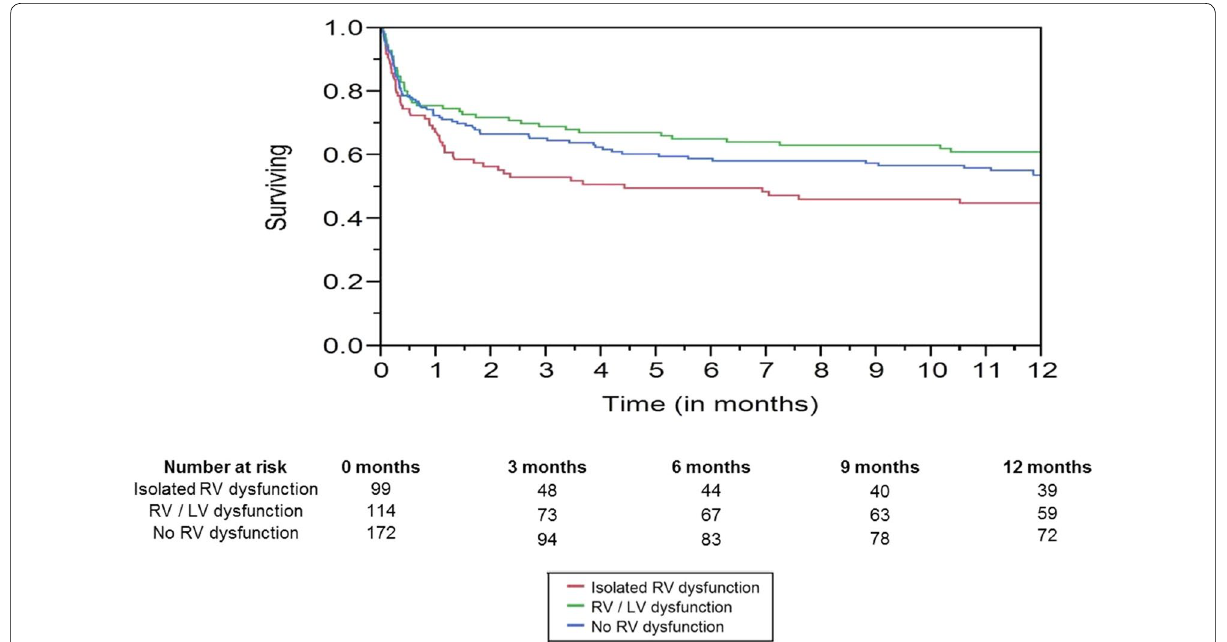
Fig. 3 1-year survival. Log-rank test p